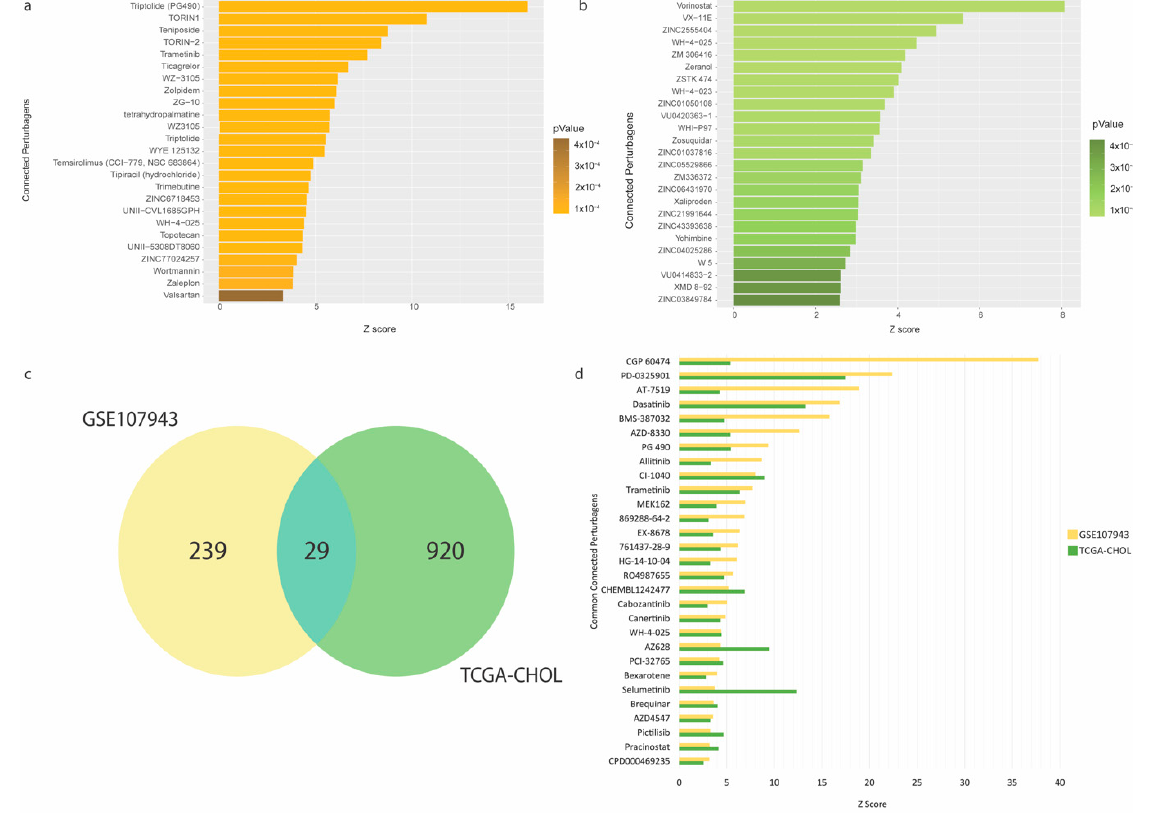
Figure 4. Pharmacogenomic connectivity analysis. ( a ) Top 25 connected perturbagens positively correlated to transcriptional changes between the low- vs. high-expression groups in the GSE107943 cohort. ( b ) Top 25 connected perturbagens positively correlated to transcriptional changes between the low- vs. high-expression groups in the TCGA-CHOL cohort. ( c ) Venn diagram depicting 29 commonly significant perturbagens between both cohorts. ( d ) Barplot showing 29 commonly significant perturbagens ranked by the connectivity z-score. Full results of pharmacogenomic connectivity mapping are provided in Tables S9–S11.